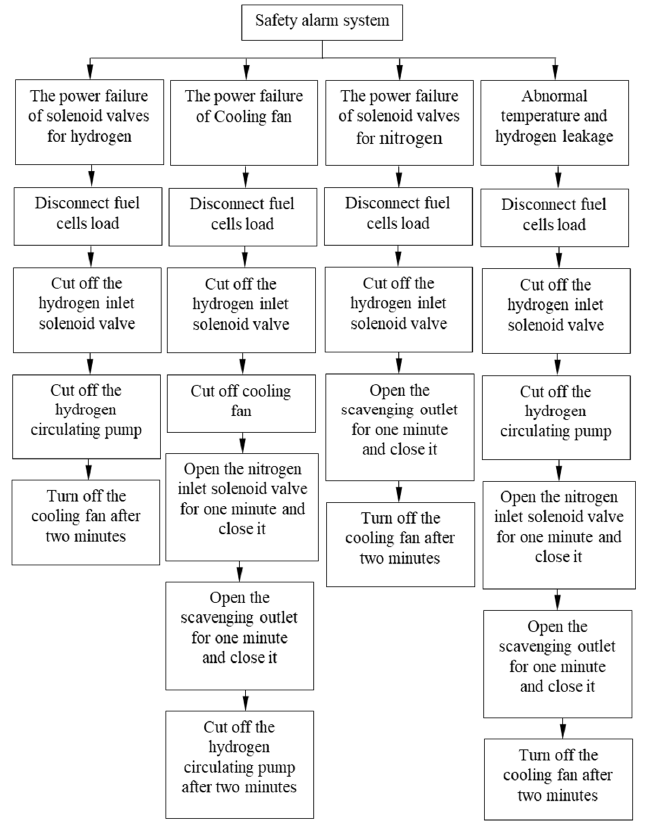
Figure 6. Flow chart of the safety alarm module.